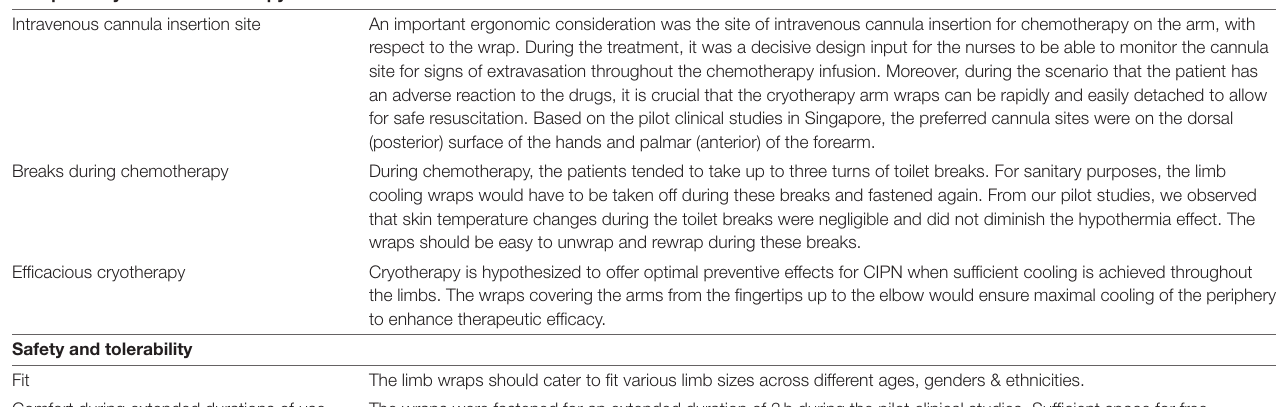
TABLE 1 | Design Requirements: Evidence-based design inputs. Compatibility with chemotherapy Intravenous cannula insertion site